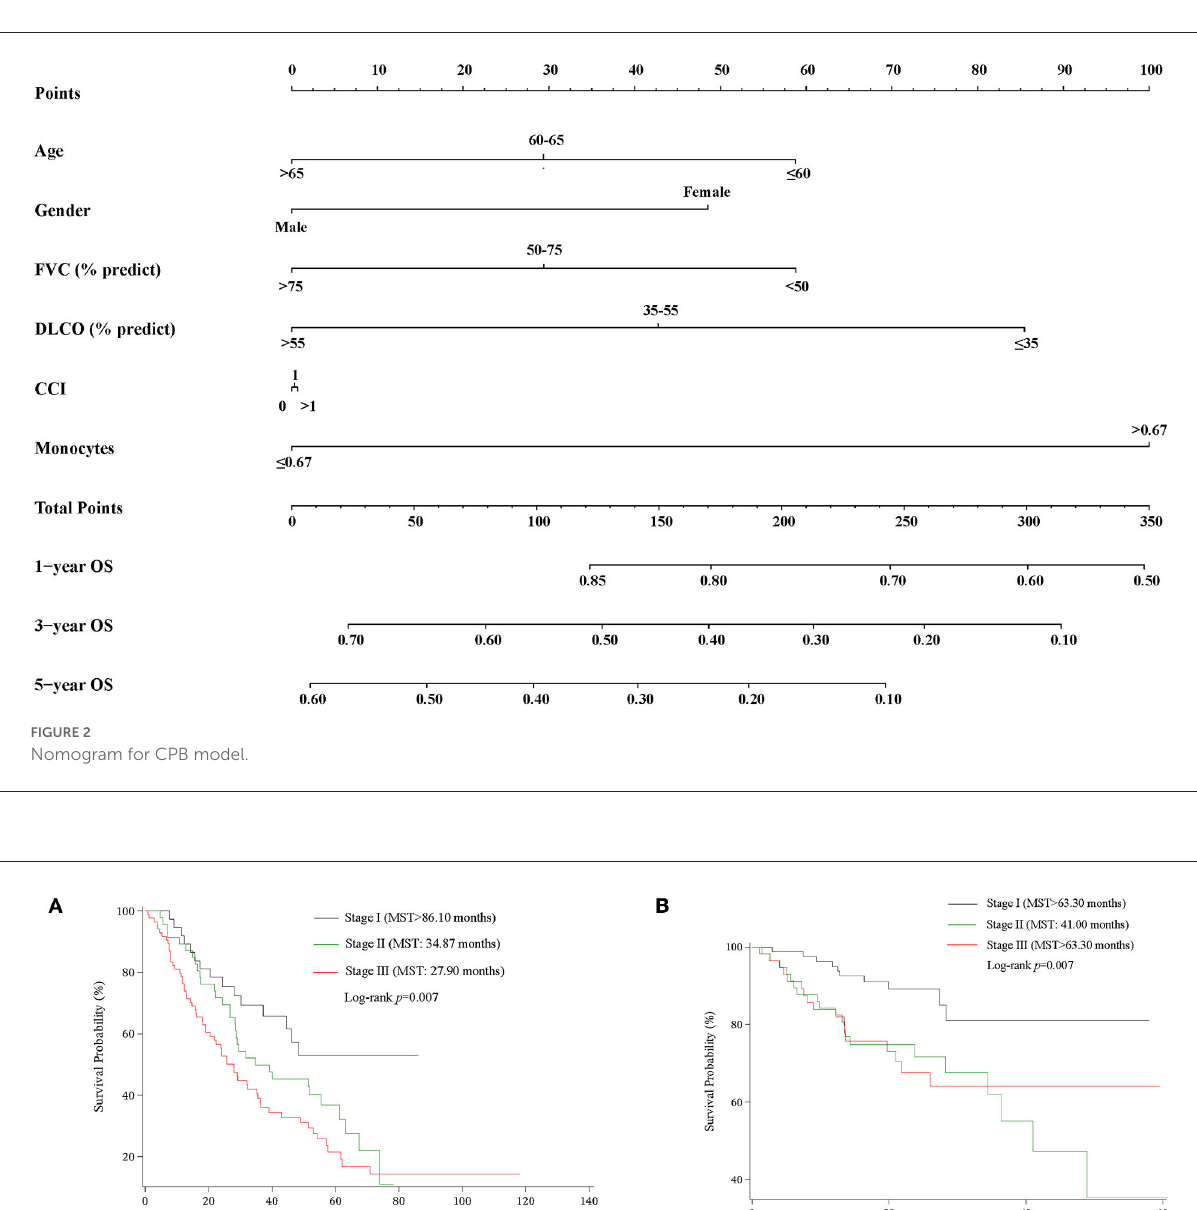
FIGURE3 Kaplan–Meier survival curve of CPB stage in derivation and validation cohort. (A) Kaplan–Meier survival curve in the derivation cohort. (B) Kaplan–Meier survival curve in the validation cohort.